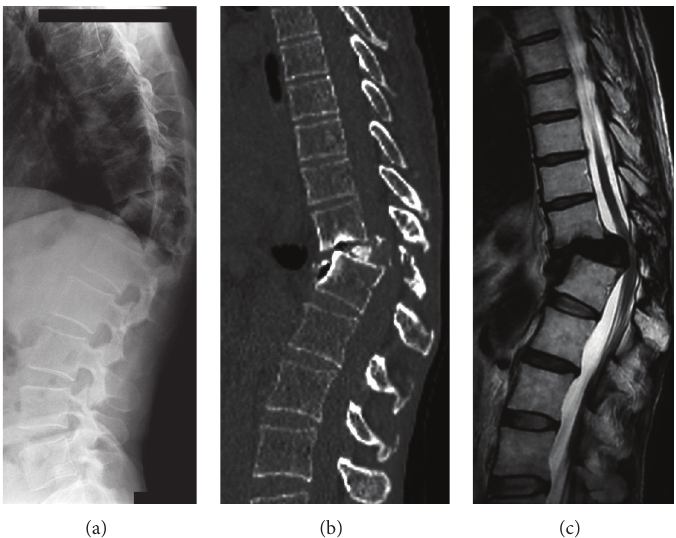
Figure 1: Images of the lumbar vertebrae on the first examination. (a) Plain X-ray radiography. (b) CT (MPR). (c) T2-weighted MRI.